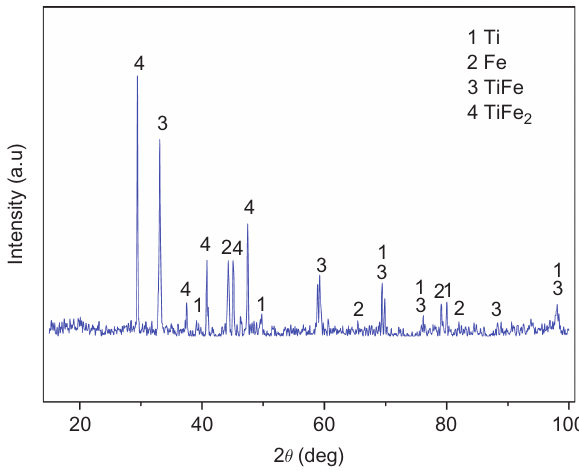
Figure 3: XRD spectra of the Fe – Ti residue after electrolyzing 6 h.